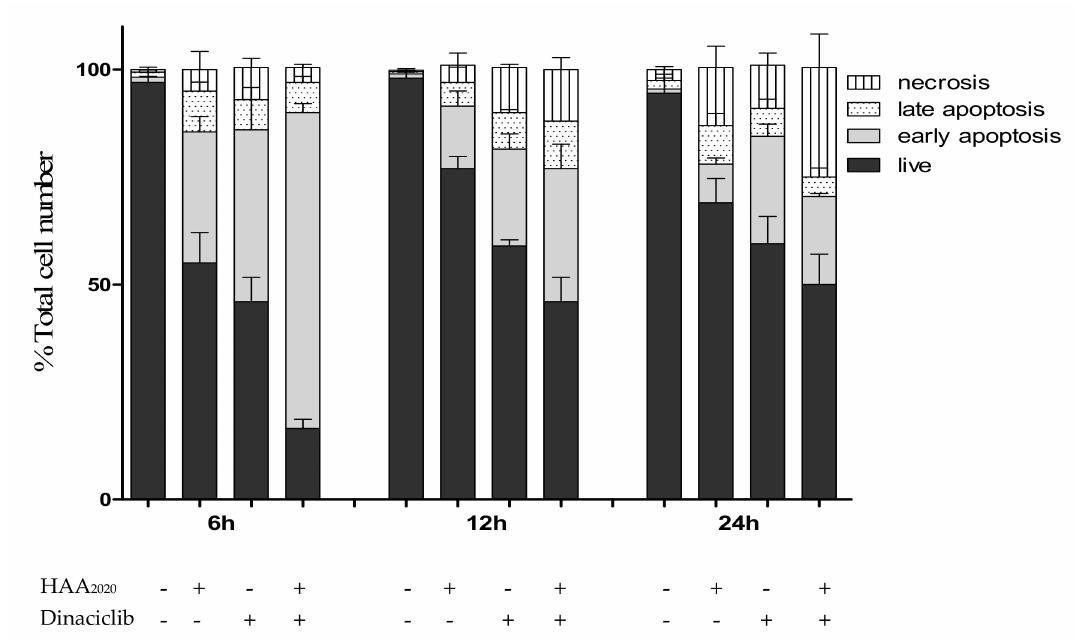
Figure 5. Detection of apoptosis in HL60 cells. Cells were treated for 6 h, 12 h and 24 h with either HAA 2020 (500 nM), dinaciclib (10 nM) or their combination. Following treatment, the cells were stained with annexin V FITC / PI. A total of 20,000 single-cell events were acquired on a BC-500 flow cytometer and analyzed by the Expo 32 software. Data are represented as mean ± SEM ( n = 3, two independent experiments) for each of the cell staining statuses: live cells (annexin V- / PI-), early apoptotic